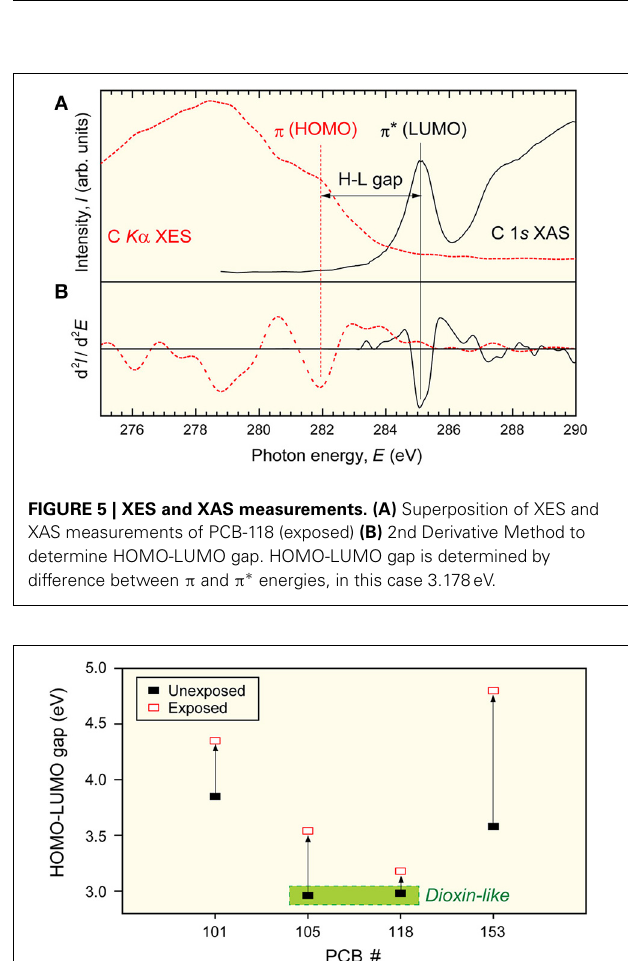
FIGURE 6 | HOMO-LUMO gaps of 4 PCBs studied. The trend is for band-gap to increase (toxicity to decrease) after exposure. PCB-118 changes least, indicating most bio-accumulative, also indicated is an experimental band-gap threshold of toxicity, similar to Figure 1